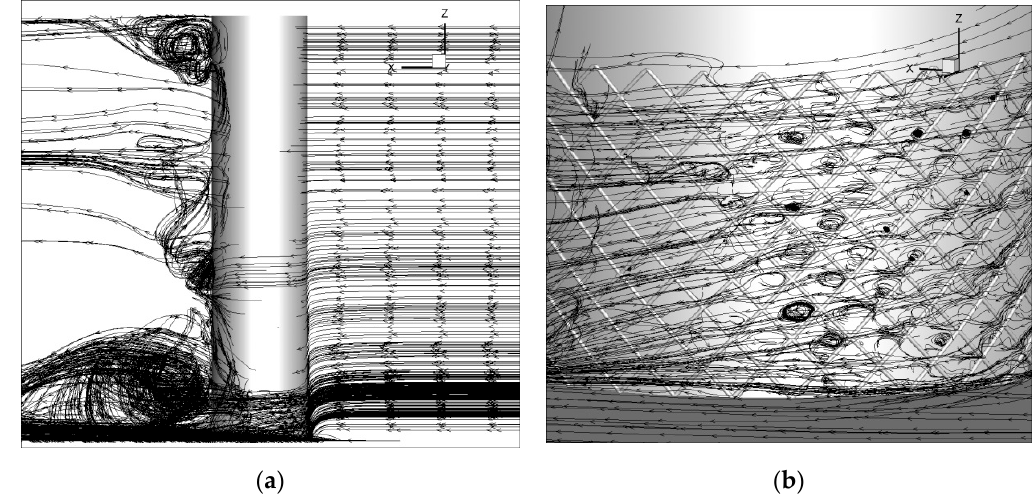
Figure 9. Streamlines after using the fishnet: ( a ) side view; ( b ) details of the flow in front of the monopile.